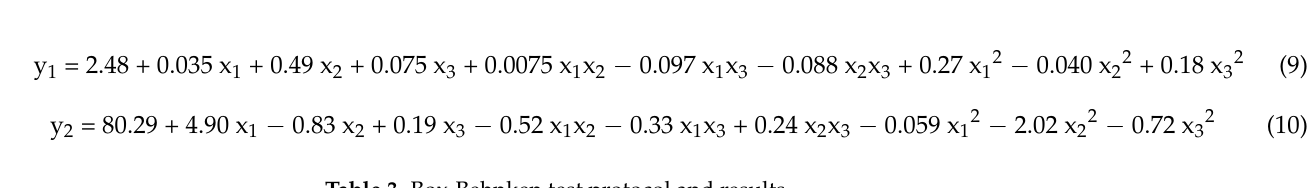
Table 3. Box-Behnken test protocol and results.